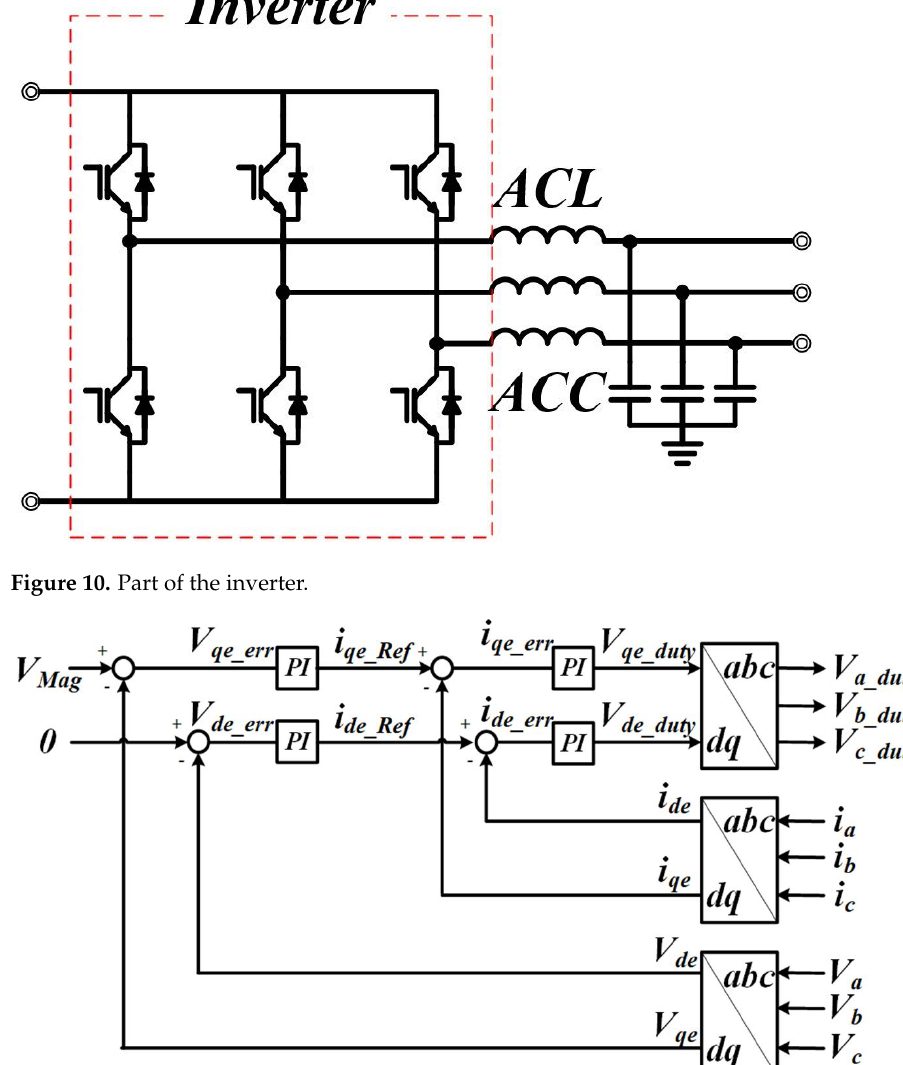
Figure 11. Control block diagram of the